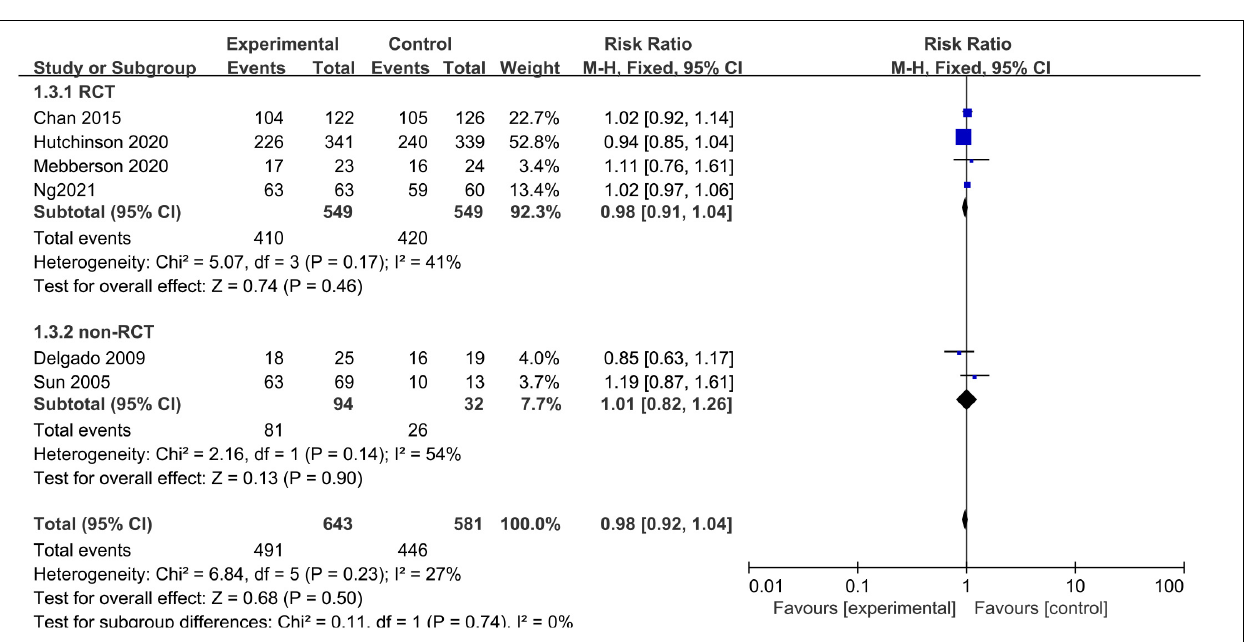
FIGURE 4 | Meta-analysis of adjuvant corticosteroid group compared to the surgery alone group on good functional outcome.